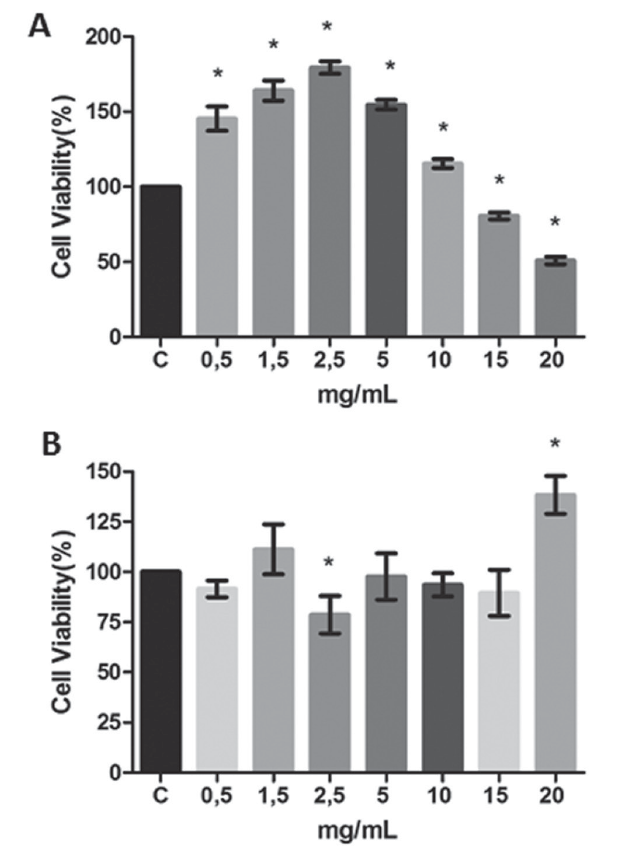
FIGURE 2 - (A) Effect of treatment with different concentrations of E. uniflora aqueous crude extract in relation to the viability of immortalized human keratinocytes cell line (HaCaT) for 24 hours. (B) Effect of treatment with different concentrations of E. uniflora aqueous crude extract on the viability of human lymphocytes for 24 hours. Data show mean and standard deviation of 3 independent experiments performed in triplicate. * P <0.05 (One-way ANOVA followed by Tukey’s